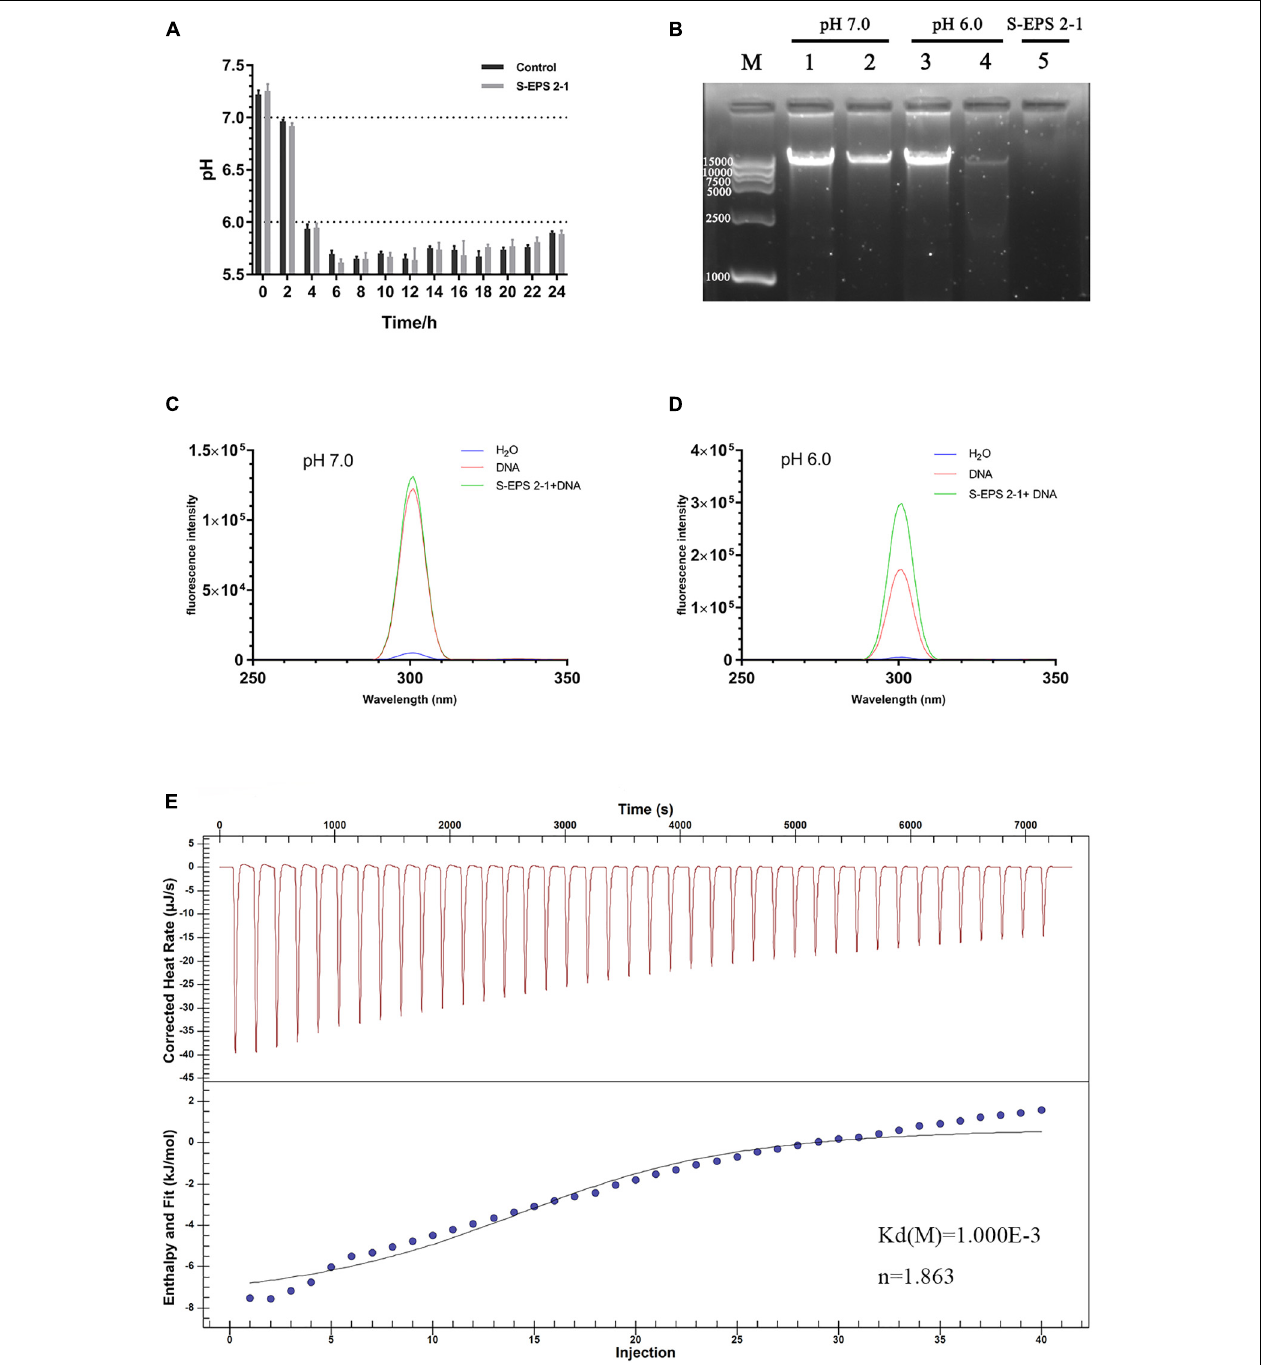
FIGURE 9 | (A) The pH changes of the culture medium of S. flexneri during 24 h cultivation. (B) The nucleic acid electrophoresis analyzed the interaction between S-EPS 2-1 and DNA. Lane M, marker DL 15000; lanes 1 and 3: DNA only; lanes 2 and 4: EPS + DNA incubated at 37 ◦ C for 30 min; lane 5: S- EPS 2-1 only. The fluorescent spectra analyzed the interaction of EPS and DNA, (C) pH 7.0; (D) pH 6.0; (E) isothermal titration calorimetry measurement to determine the interaction between S-EPS 2-1 and